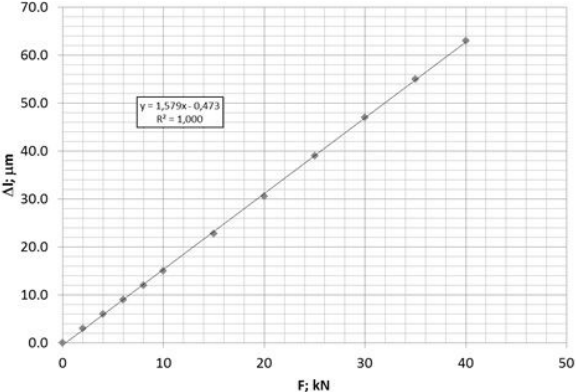
Figure 17: Characteristics describing the dependence of the bolt’s elongation in the function of tensile force